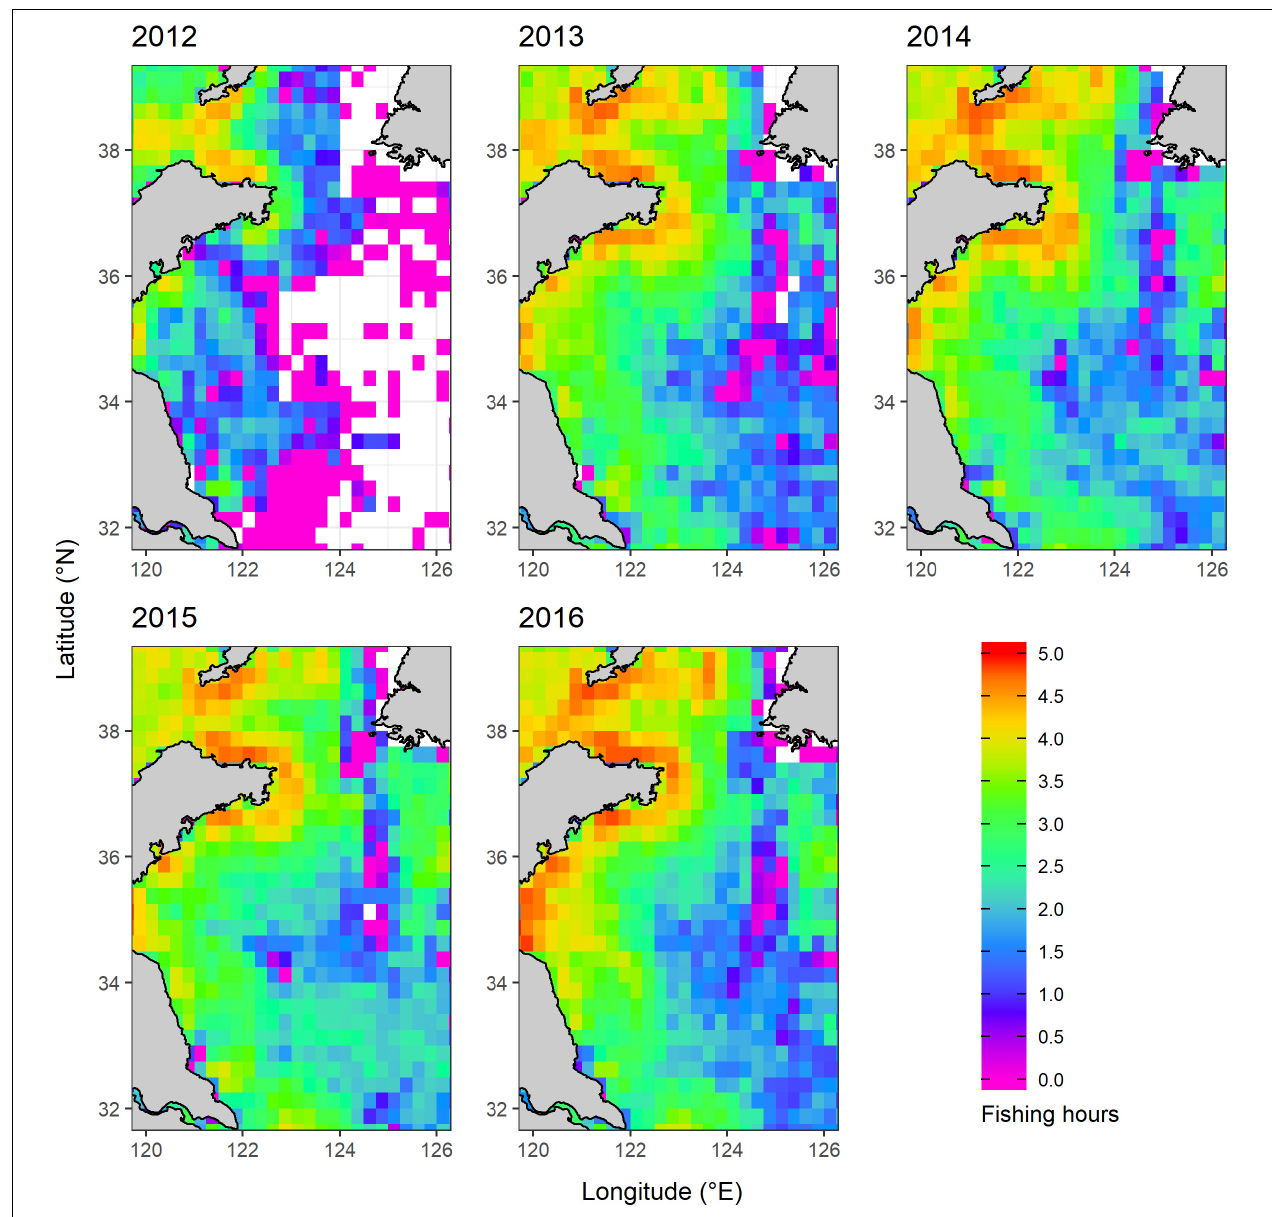
FIGURE 2 | Spatial and temporal distribution of fishing intensity (represented by log transformed fishing hours) in the Yellow Sea.